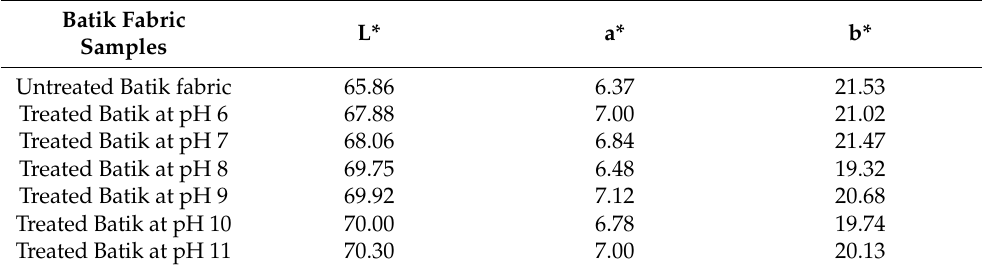
Table 3. The value of L*, a*, and b* of untreated and ZnO NPs-treated ND-colored Batik fabric. Batik